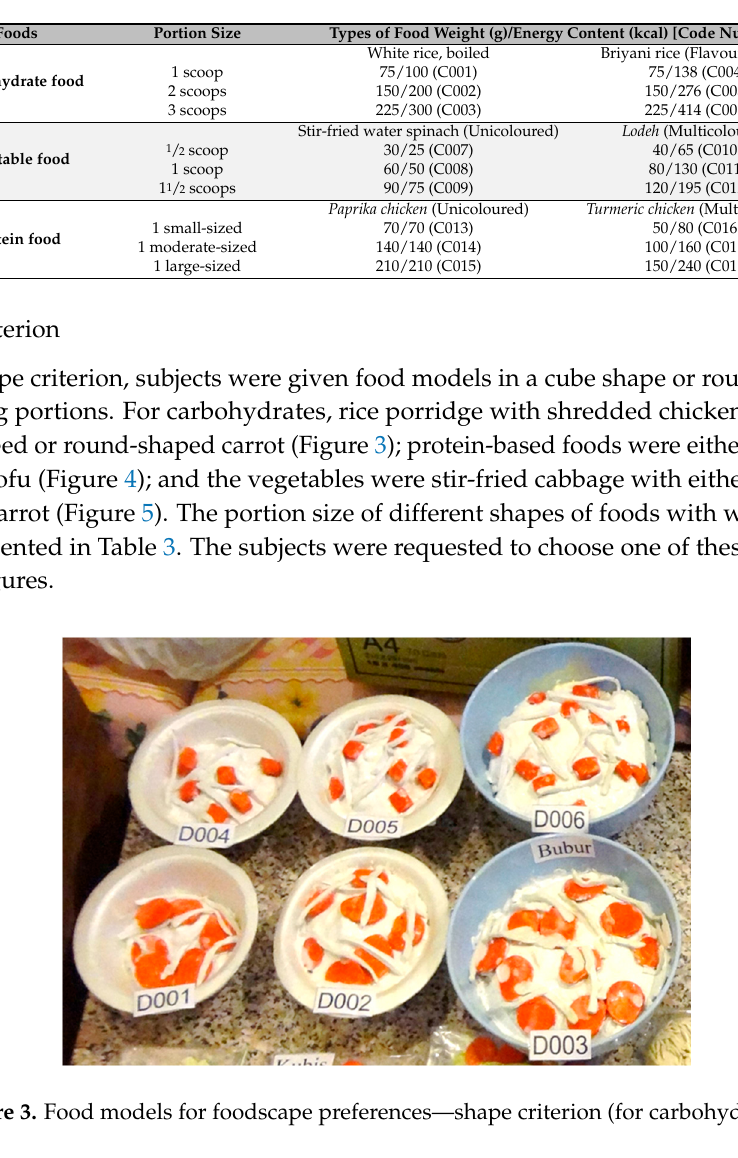
Figure 4. Food models for foodscapes preferences—shape criterion (for proteins). Figure 5. Food models for foodscapes preferences—shape criterion (for vegetables). Table 3. Portion size of different shapes of foods with corresponding weight and energy content. Foods